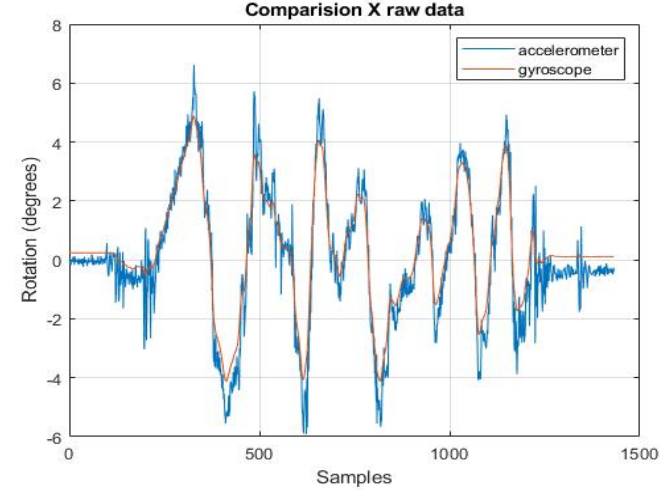
Figure 9. X-axis rotation readings from accelerometer and gyroscope.